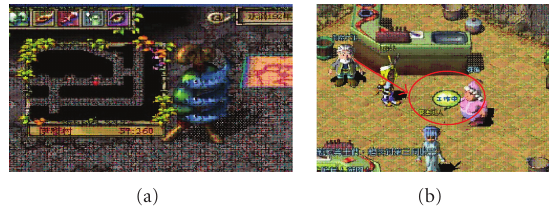
Figure 5: (a) The map, (b) player